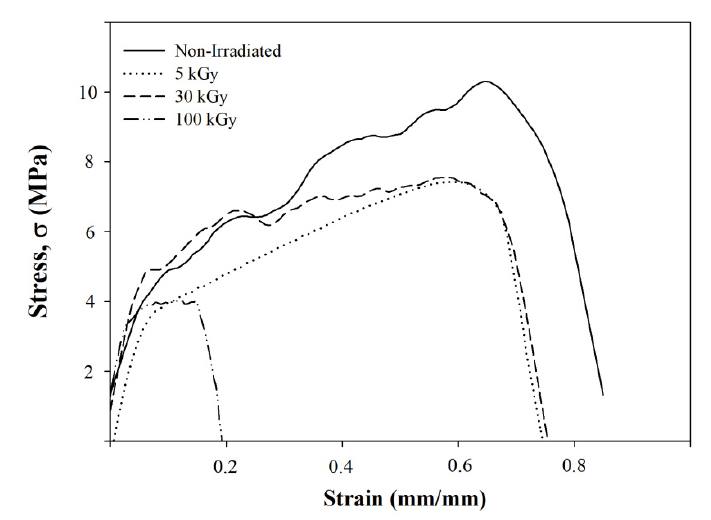
Figure 10. The e ff ect of electron-beam irradiation to the breaking behavior of PLLA / CMS / β - Figure 10. The effect of electron-beam irradiation to the breaking behavior of PLLA/CMS/ β -TCP TCP nanofibers.